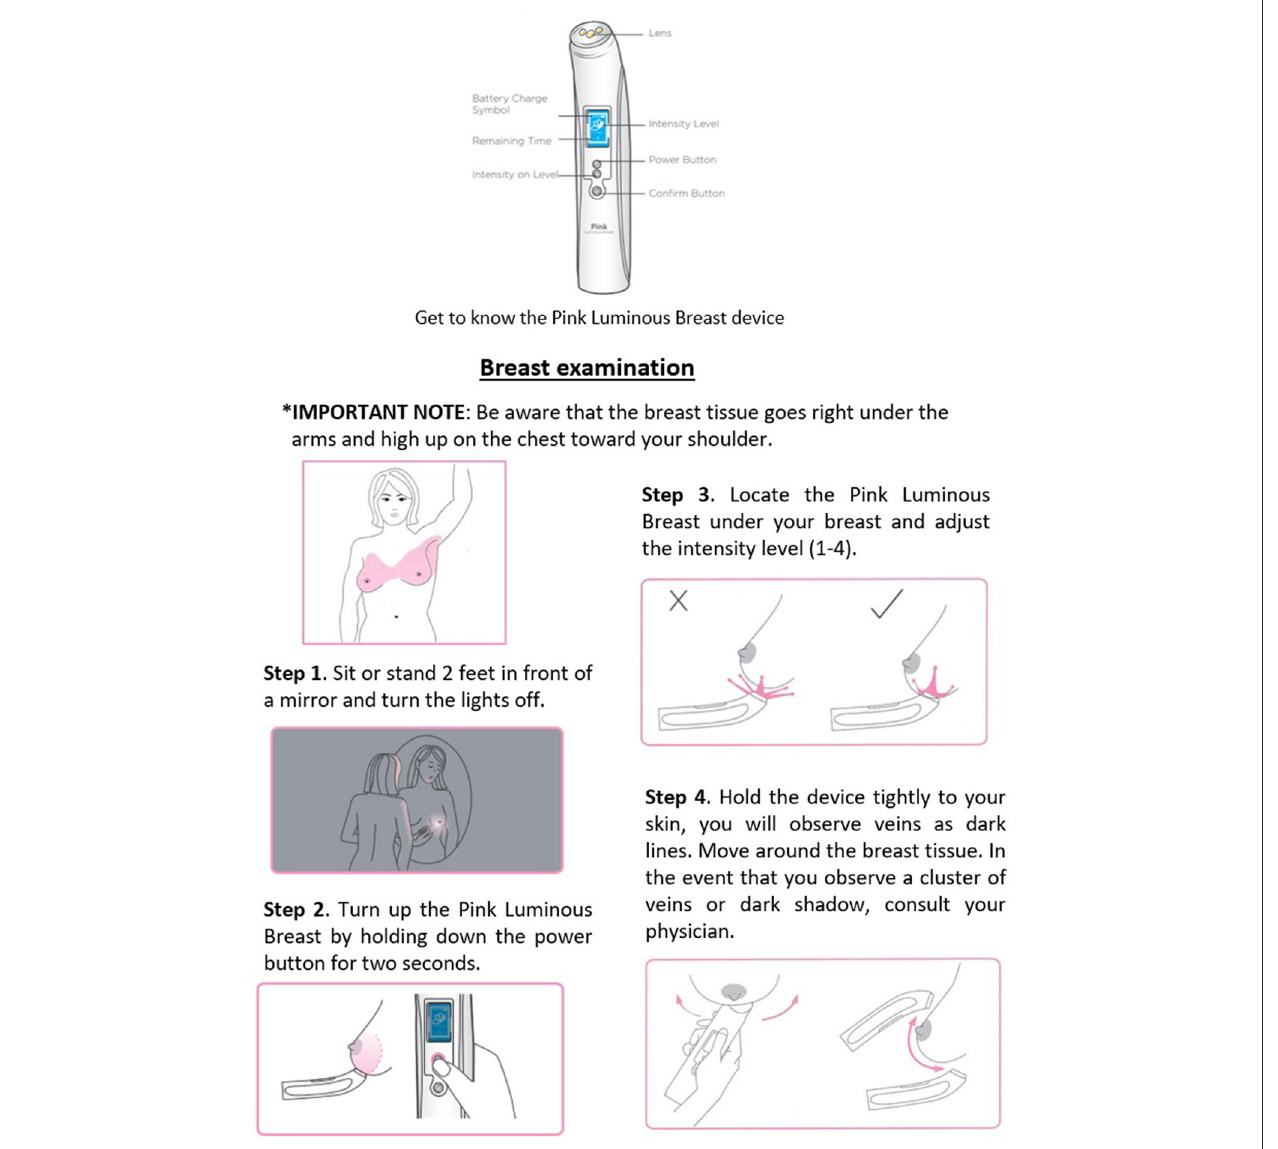
FIGURE 2 | Summary of pink luminous breast